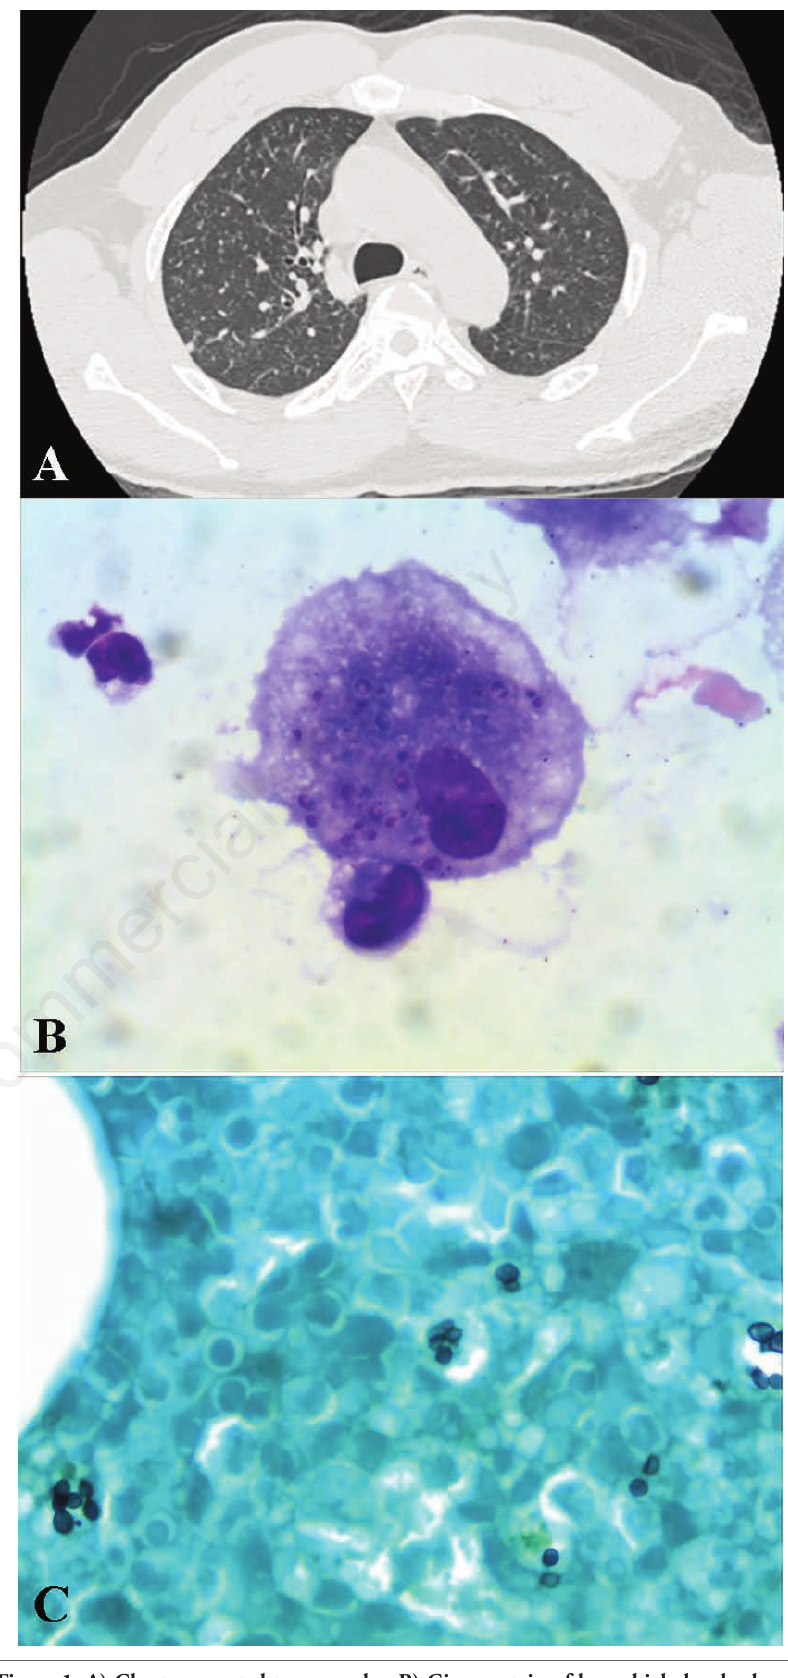
Figure 1. A) Chest computed tomography; B) Giemsa stain of bronchial alveolar lavage showing macrophages with intracellular organisms (100×); C) Grocott's methenamine silver stain of bone marrow showing yeasts